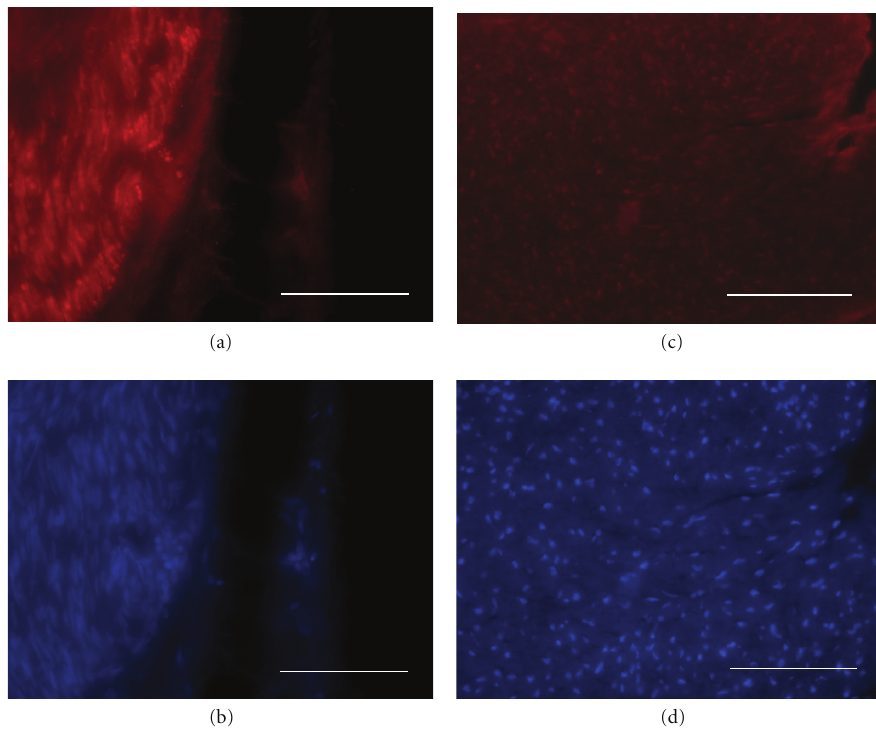
Figure 8: CNPase immunohistofluorescence on sagittal sections of venous bridges without (a, b) or with (c, d) transplantation of LV-GFP- labeled neurospheres, which had been sampled 240 days after lesion. Alexa-594 fluorescence-revealed CNPase immunoreactivity (a, c) is combined with histofluroescent DAPI counterstaining (b, d). Note that Schwann cell labelling density is strikingly higher in neurosphere- transplanted graft (c, d) than in void venous bridge (a, b). Σ χαλεβαρσ : 100 μ